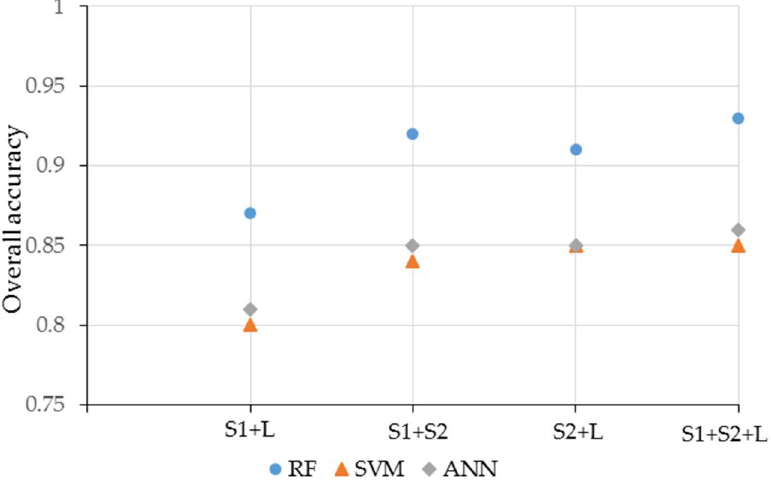
Figure 7. Performance of the three classifiers from Figure 6 for the four classification scenarios.